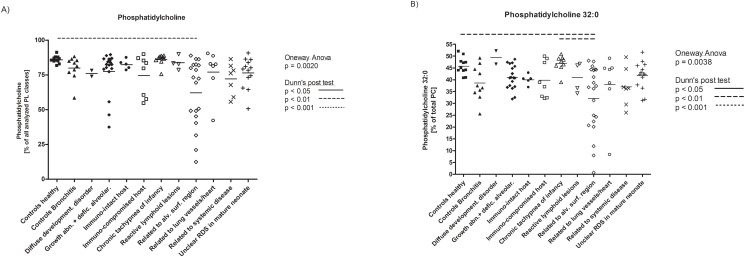
Display of results at the disease category level.A) Phosphatidylcholine, the major surfactant phospholipid class and B) its species dipalmitoylphosphatidylcholine (PC 32:0) are given as individual results of all patients included in the study according the disease category they belong to. The statistical comparisons were done by ANOVA and Dunn’s post hoc test; all significant results are displayed in each figure. To take multiple comparisons into consideration, an overall cut-off level of P<0.0182 was calculated. For A) 1-way ANOVA gave a P = 0.0020, for B) P < 0.0038; the significant results of Dunn’s post hoc tests are indicated as following: ____ = P < 0.05, _ _ _ = P < 0.01, and …. = P < 0.001. The species of the other phosphatidylcholines, the other phospholipid classes and their species composition are displayed in S3 Fig. Horizontal bar indicates median.